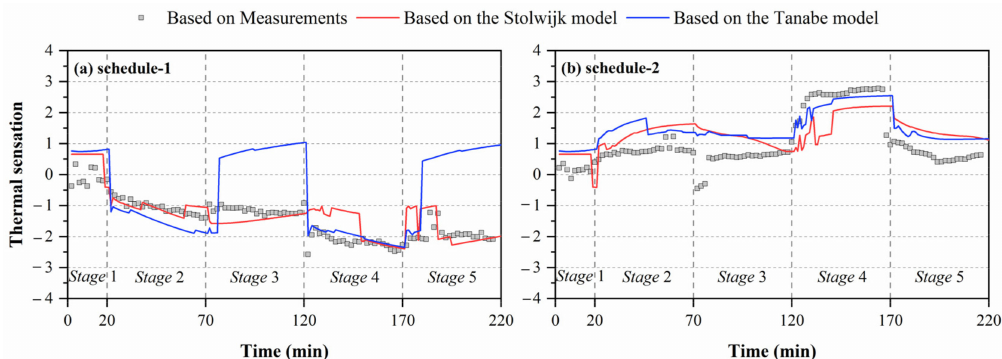
Figure 6. Comparisons of predicted thermal sensation based on local skin temperatures measured by experiments and calculated by the Stolwijk model and Tanabe model, ( a ) schedule 1, ( b ) schedule